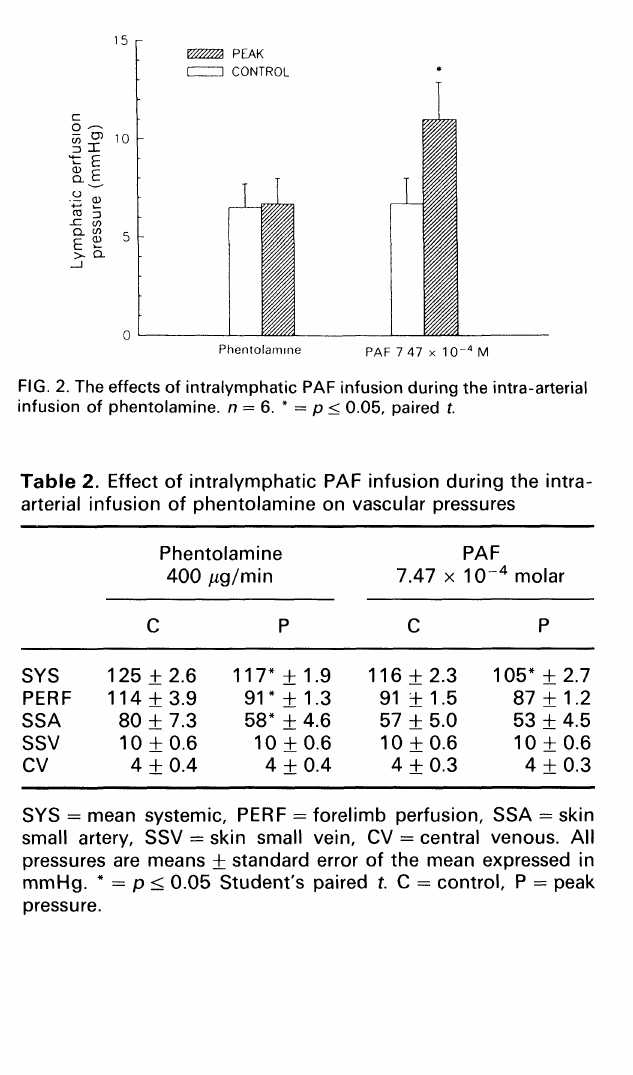
FIG. 3. The effects of intralymphatic PAF infusion during the intra-arterial infusion of the PAF receptor antagonist WEB 2170. n 6. p < 0.05,